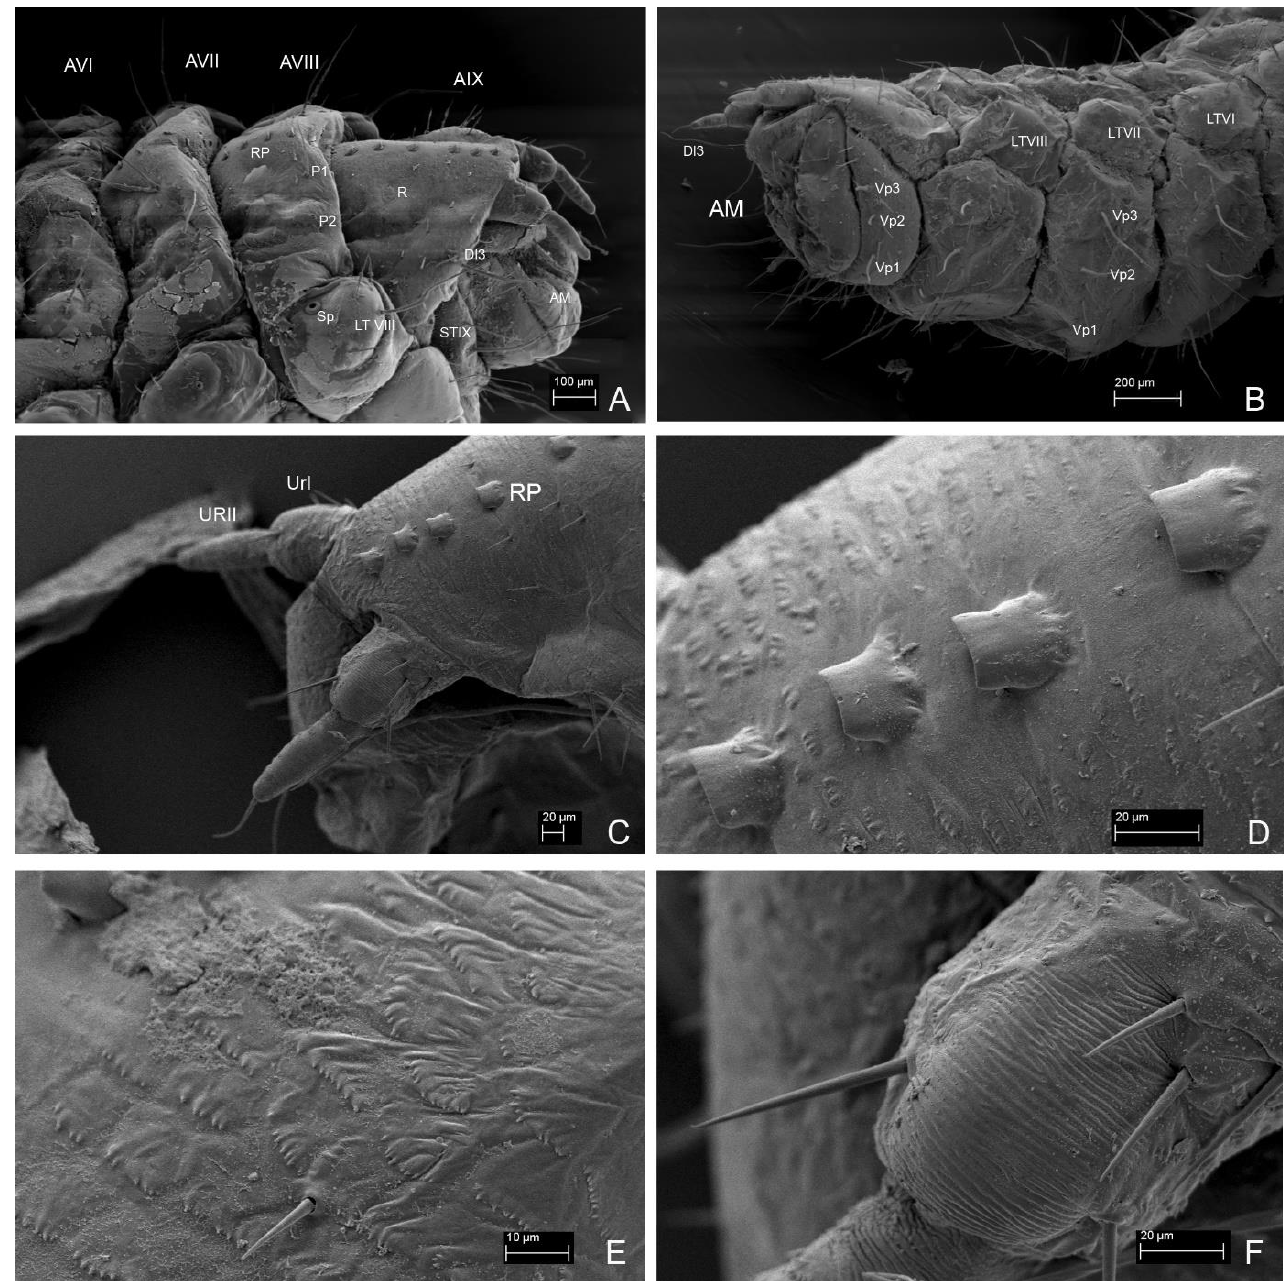
Figure 15. Leiodes cinnamomea. Details of larval morphology of instar III. ( A ) Abdominal tergites and laterotergites VI–IX and anal membrane. ( B ) Abdominal sternites and laterotergites VI–IX and anal membrane. ( C ) Abdominal tergite IX with median row of sclerotized plates and urogomphi. ( D ) Sclerotized plates of abdominal tergit IX. ( E ) Microsculpture of abdominal tergite IX. ( F ) Details of microsculpture of urogomphi. Abbreviations: AI–IX—abdominal tergites I–IX; AM—anal membrane; LTVI–IX—laterotergites VI–IX; R—reservoir; RP—rectangular plate; Sp—spiracle; UrI, II—urogomphere I, II. The other abbreviations refer to the terminology of setae.